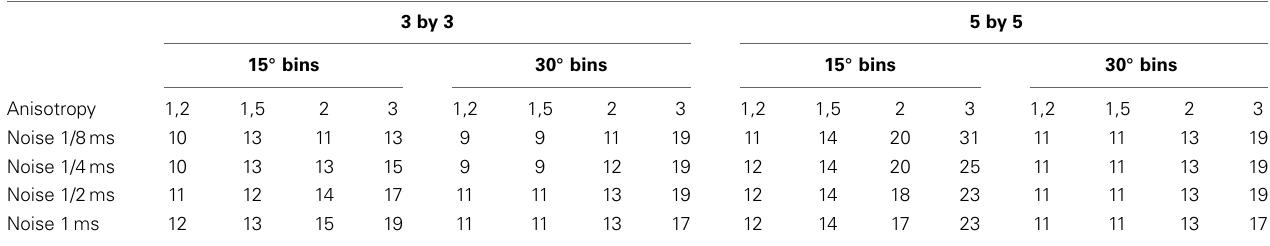
Table 1 | Minimum required size of grid to have a 95% chance of having at least one vector in the bin representing the direction of the